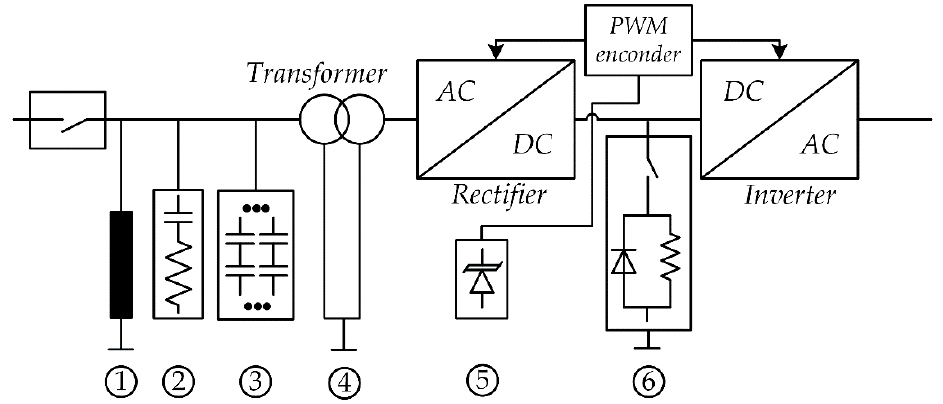
Figure 12. Protection methods for overvoltage mitigation wherein ① : Surge arresters. ② : RC absorption circuit. ③ : Proposed method. ④ :Grounding. ⑤ : Transient Voltage Suppressor. ⑥ : Crowbar circuit. Table 2. Features of several methods for the overvoltage suppressor.